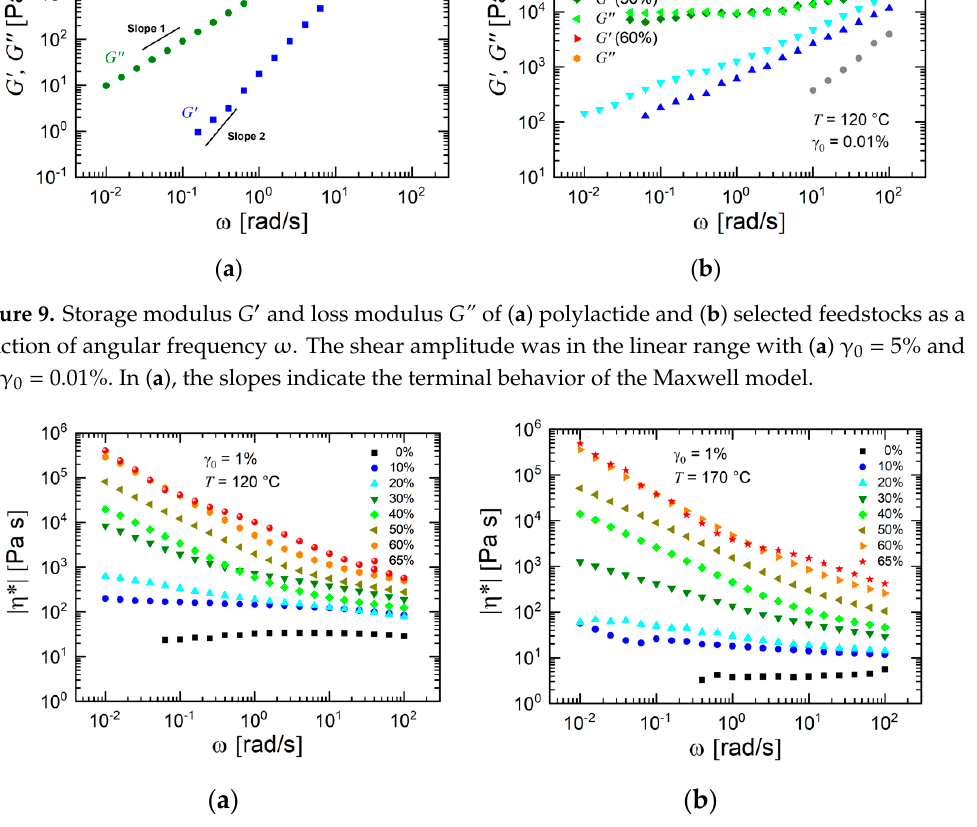
Figure 10. Magnitude of complex viscosity η * of the prepared feedstocks at a test temperature of ( a ) 120 °C and ( b ) 170 °C. The shear amplitude γ 0 was equal to 1%.